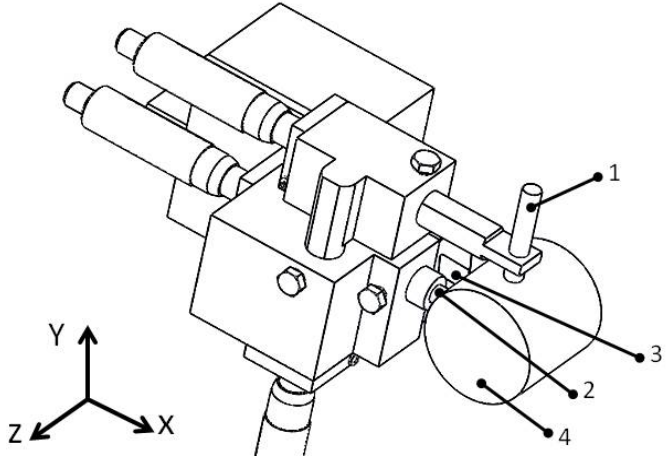
Figure 2. Scheme of the measuring head mounted on the lathe: (1) Eddy Current Sensor 1; (2) Eddy